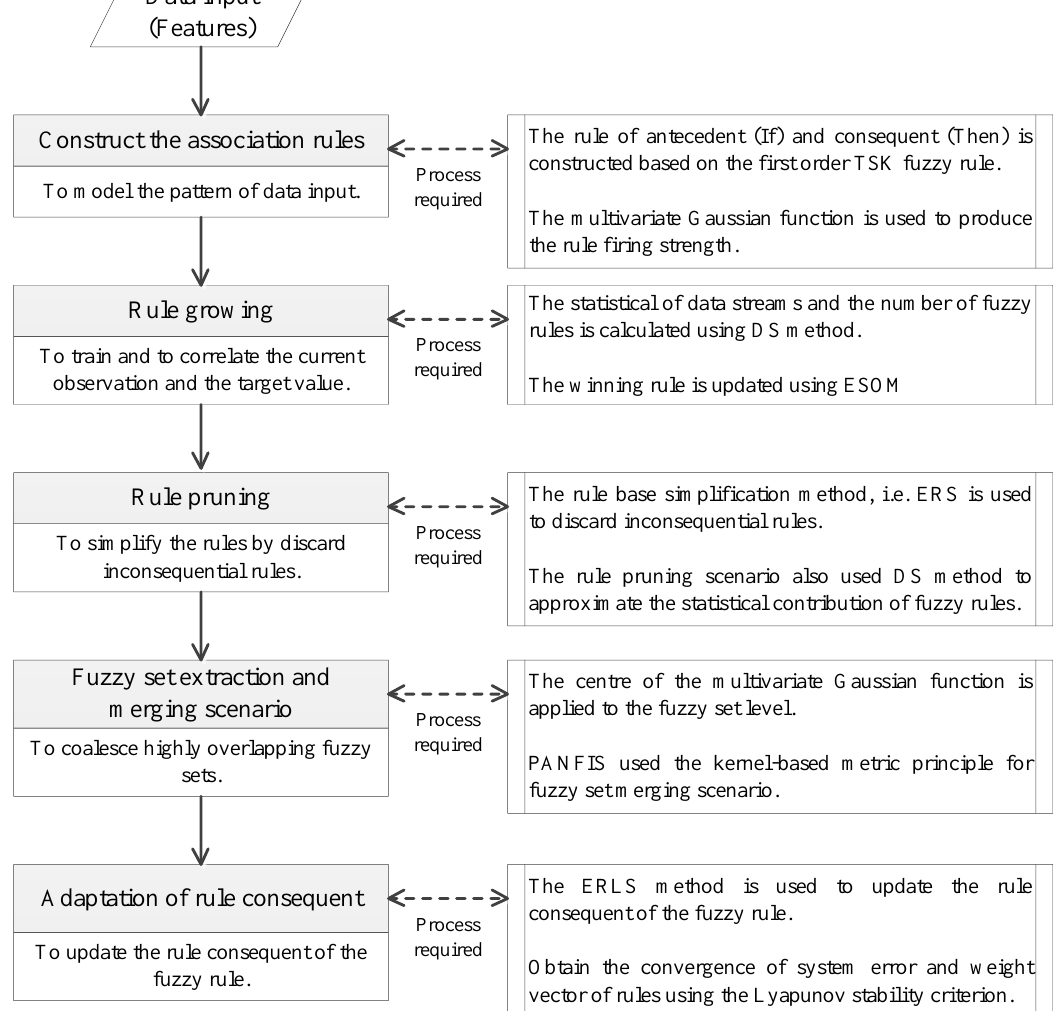
Figure 5. An architectural scheme of the PANFIS method.